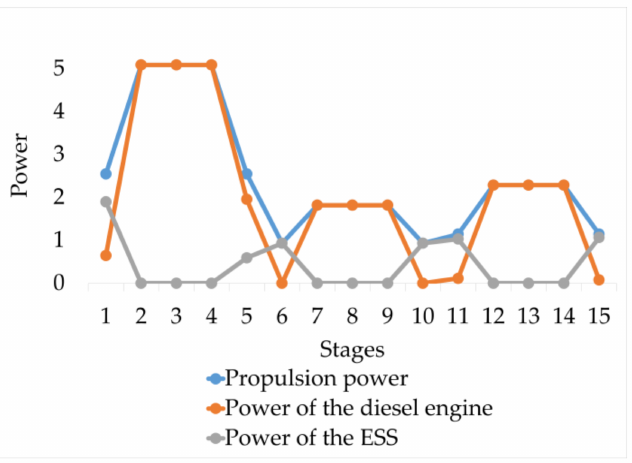
Figure 6. Comparison of propulsion power, diesel engine power, and ESS power under no wind and waves.